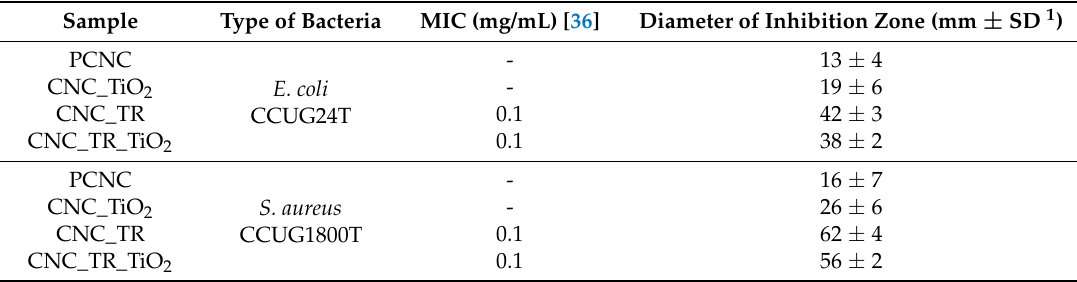
Table 2. The measurements of antimicrobial activity of the obtained